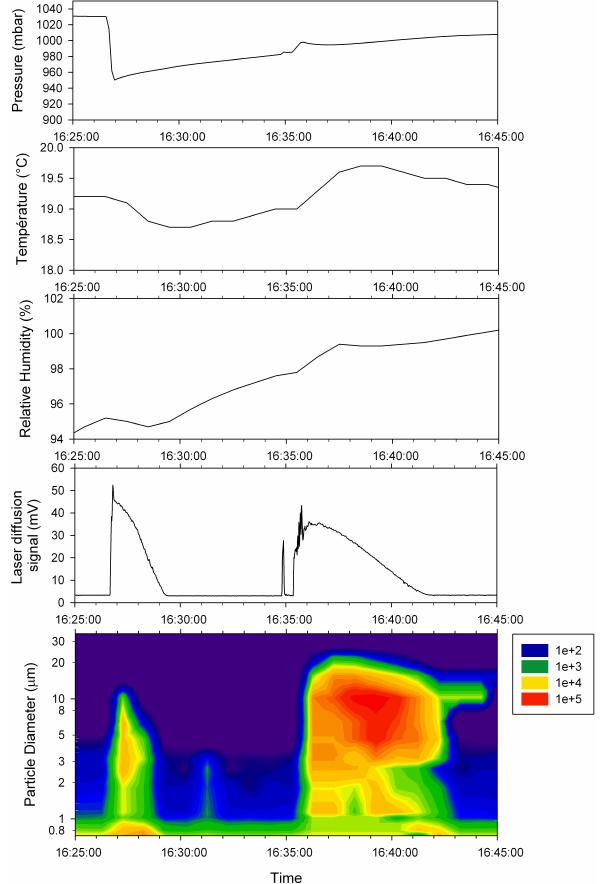
Fig. 14. Cloud generation experiments. Two cloud events are gen- erated: the first from fast expansion and the second by progressive saturation. Panels from top to bottom: pressure, temperature and relative humidity in the CESAM chamber, laser diffusion signal and aerosol mass concentration derived from Grimm TM Aerosol Spec- trometer measurement assuming a refractive index of 1.33–0.0 × i .